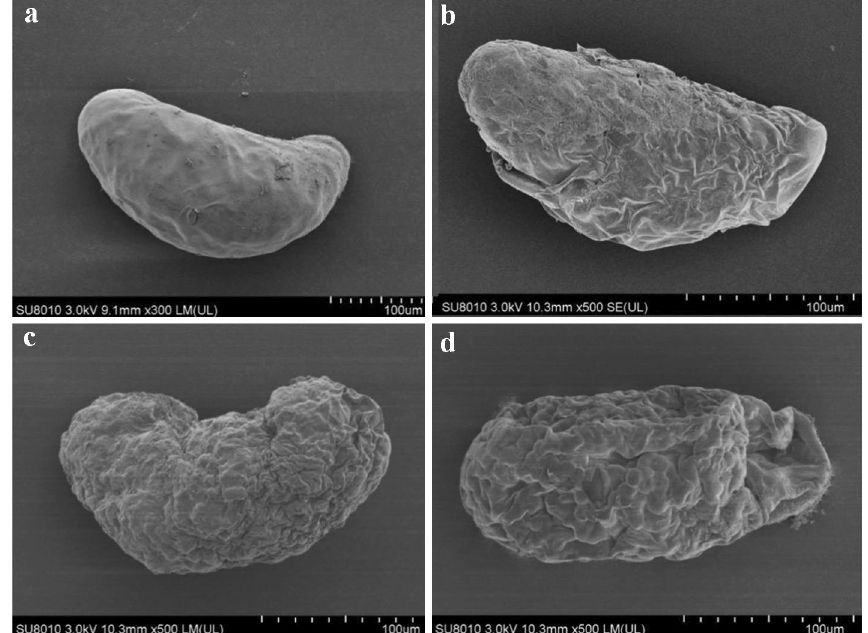
Figure 7. The effect of spirotetramat on the surface of egg shells of F. occidentalis 0-h-old eggs. ( a ) 0-h-old eggs in the control treatment; ( b ) eggs shells were shed 24 h after treatment with spirotetramat; ( c ) the surface of the egg shell was uneven and severely wrinkled; ( d ) the pores of some eggs were sunken down and shrunken after treatment with spirotetramat.